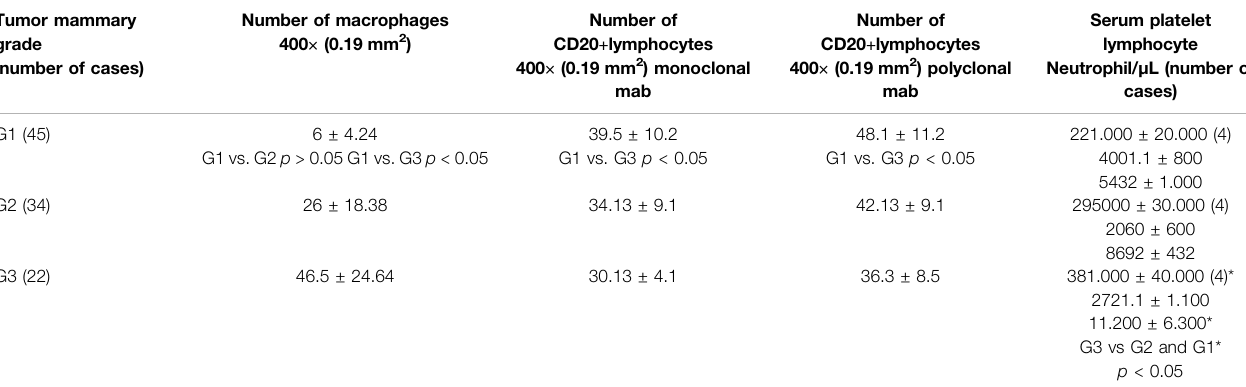
TABLE 3 | Macrophages and lymphocytes as a function of malignancy grade of canine breast